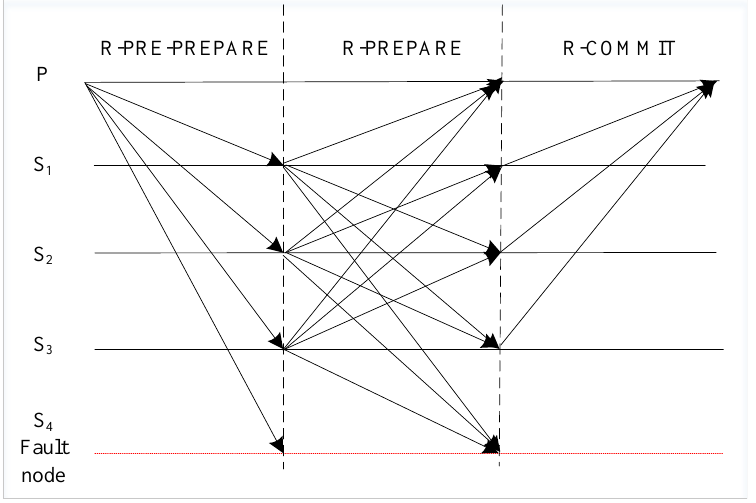
Figure 2. Execution flow of a round of consensus.